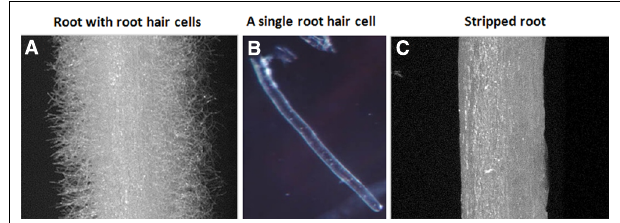
FIGURE 1 | Soybean root hairs and stripped roots. (A) Root with root hairs, (B) A representative of single cell root hair and (C) stripped roots (i.e., root hairs removed from